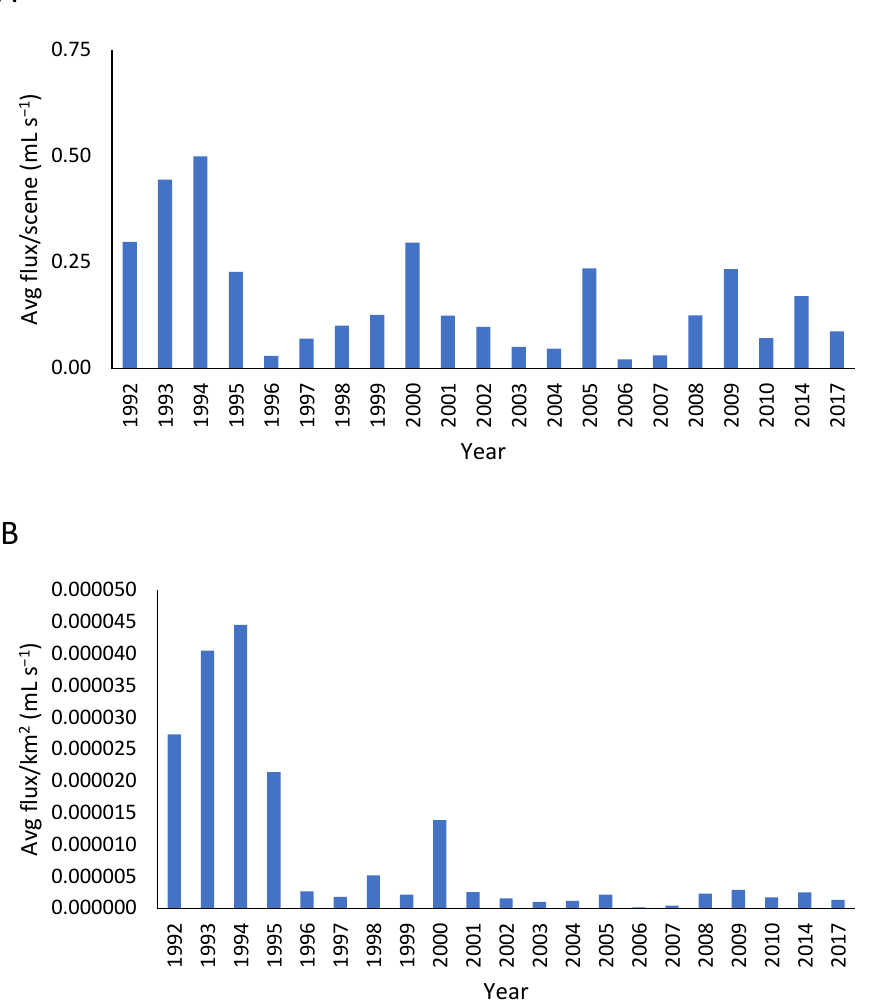
Figure 5. Temporal variation of average flux of natural OSOs in the Gulf of Mexico. ( A ) Average flux is normalized by the number of scenes containing oil slicks per year. ( B ) Average flux is normalized by the area of scenes containing oil slicks per year. Years with <50 total scenes were excluded for this